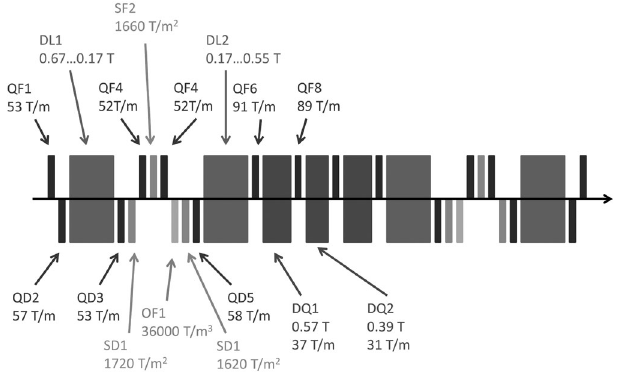
FIG. 1. Schematic view of one cell of the ESRF-EBS lattice. The storage ring will be made of 32 cells. QF, QD: quadrupoles; SF, SD: sextupole; OF: octupole magnets; DL: dipole with longitudinal gradient; DQ: dipole-quadrupoles. The fast correc- tors are not